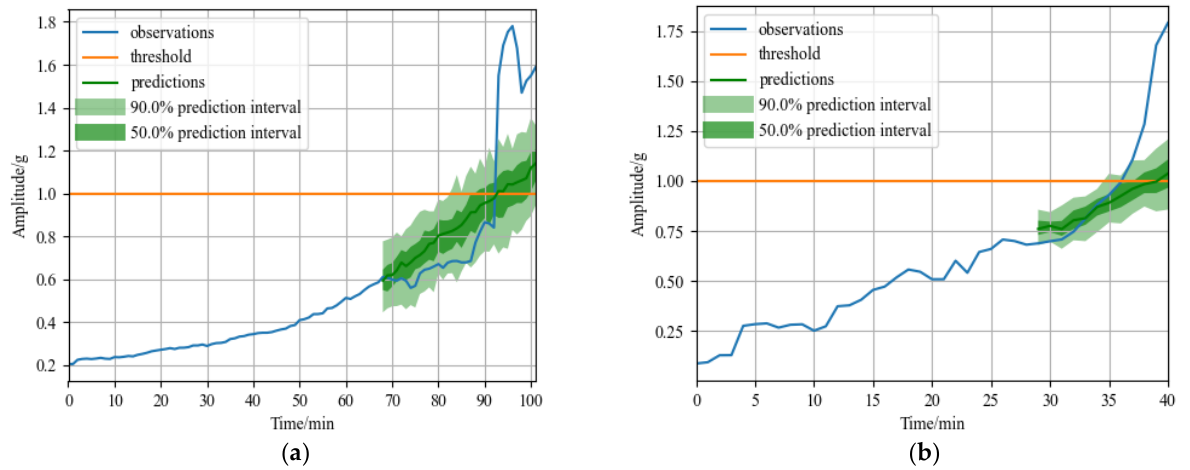
Figure 7. RUL prediction results of XJTU-SY dataset: ( a ) RUL prediction result of rolling bearing1_3; and ( b ) RUL prediction result of rolling bearing2_1.